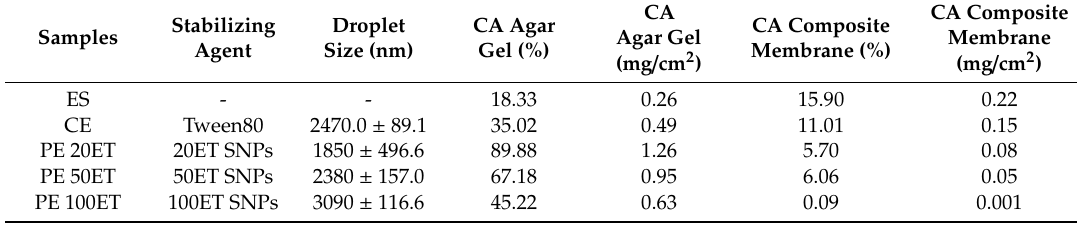
Table 4. Results of in vitro di ff usion studies. ES: ethanolic solution, CE: conventional emulsion, PE: Pickering emulsion, CA: cumulative TIO amount after 2 h. The concentration of TIO was 3.58 mg / mL in each formulation.